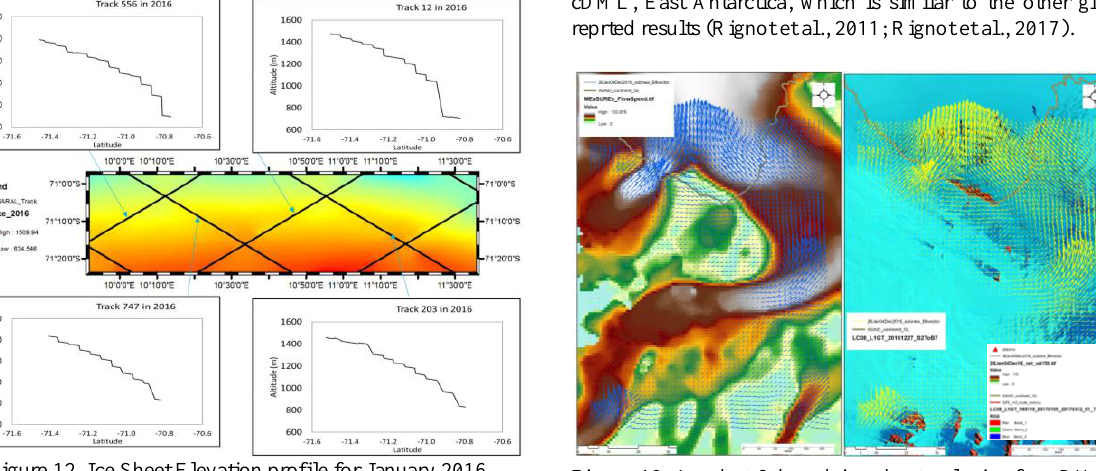
Figure 13. Landsat-8 based ice sheet velocity for cDML and Somovken ice stream for year 2016